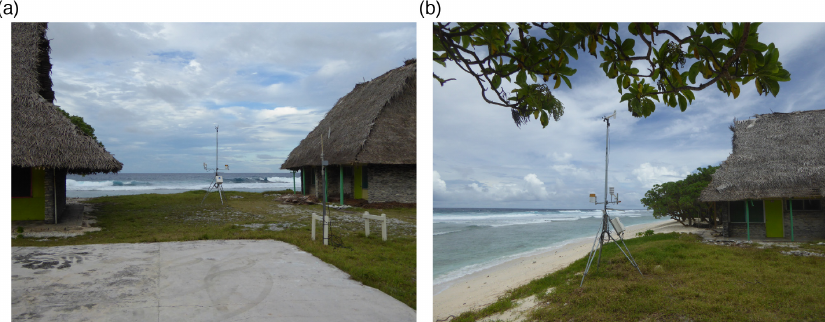
Figure 3. The original position of the surface instruments (a) , and their location after being moved back towards the top of the beach on 5 February 2017 (b)